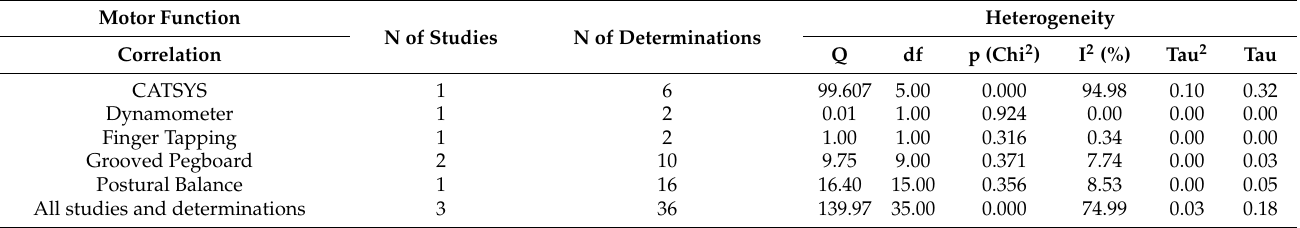
Table 5. Correlation between motor function and exposure to Mn. Overall heterogeneity and as a function of the motor test used. Motor Function N of Studies N of Determinations